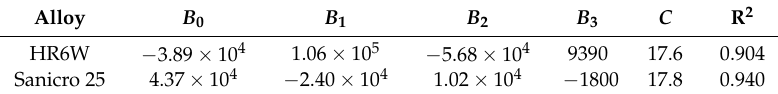
Table 6. MATLAB calculations of the LMP coefficients and goodness of fit.